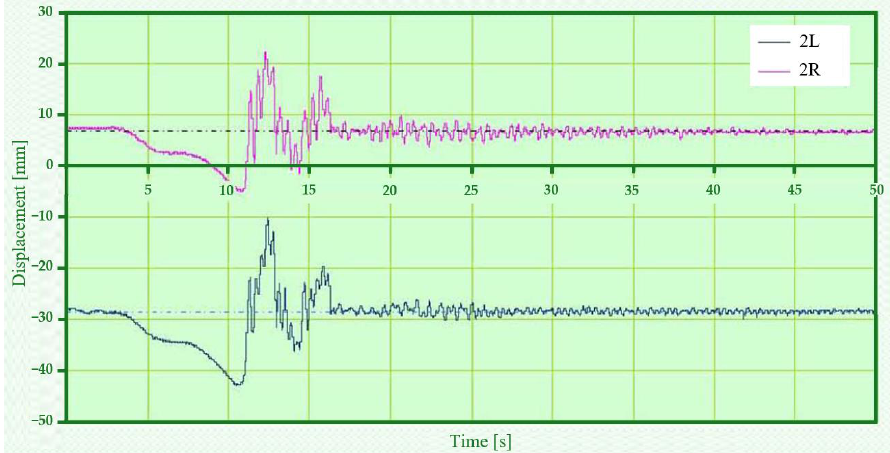
Figure 19. Relative deflections between car body and chassis frame—variant B-III.